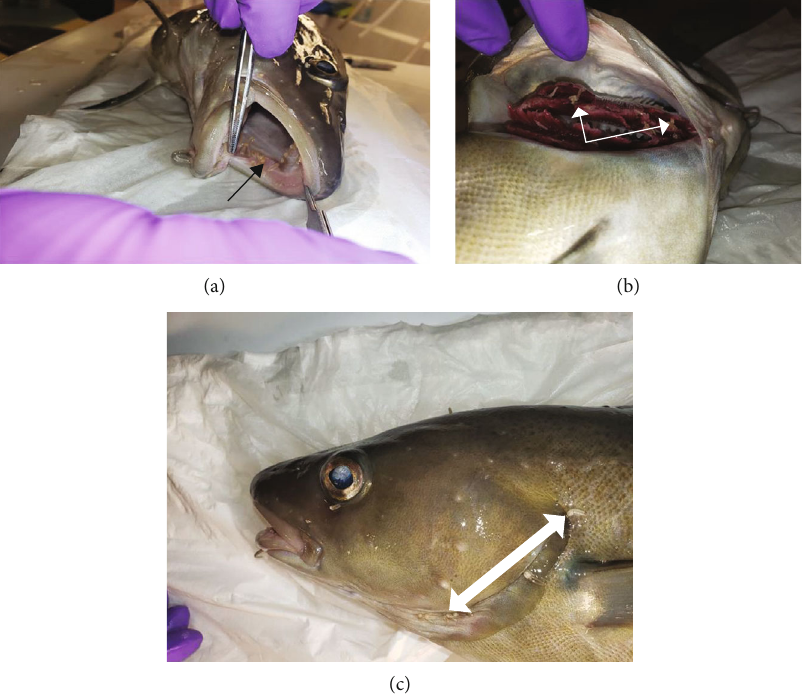
Figure 1: Anatomical distribution of presumptive Clavella sp. infesting Gadus morhua. (a) Oral cavity (black arrow). (b) Gill fi laments and arch (white arrows). (c) External operculum (black arrows).